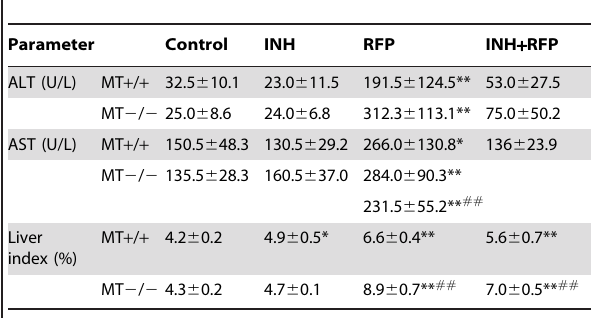
Table 1. Effect of INH and RFP treatment on plasma ALT, AST activities and liver index of wild-type (MT + / + ) and MT 2 / 2